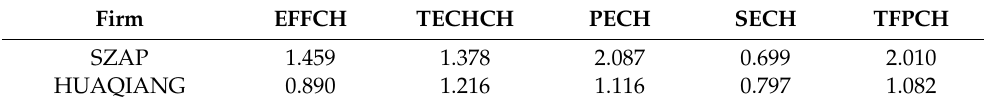
Table A7. MPI of 45 Enterprises not using the new retail